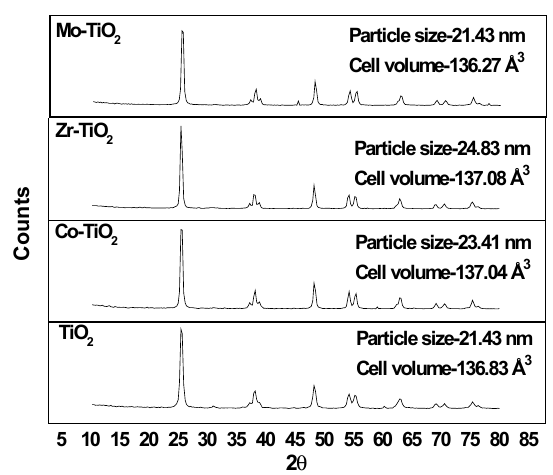
Figure 1. X-ray diffraction patterns of